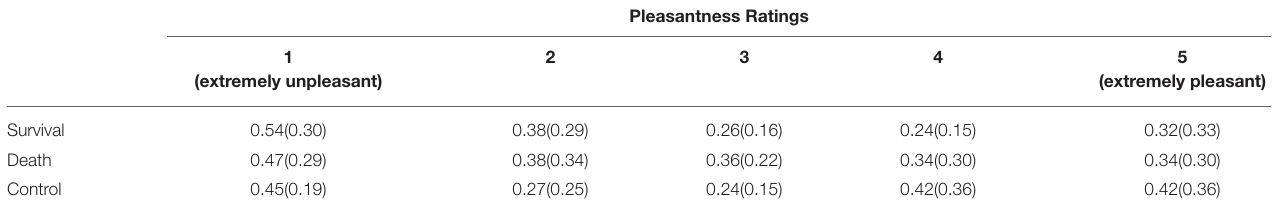
TABLE 5 | Mean proportions of words recalled as a function of experimental condition and pleasantness rating in Experiment